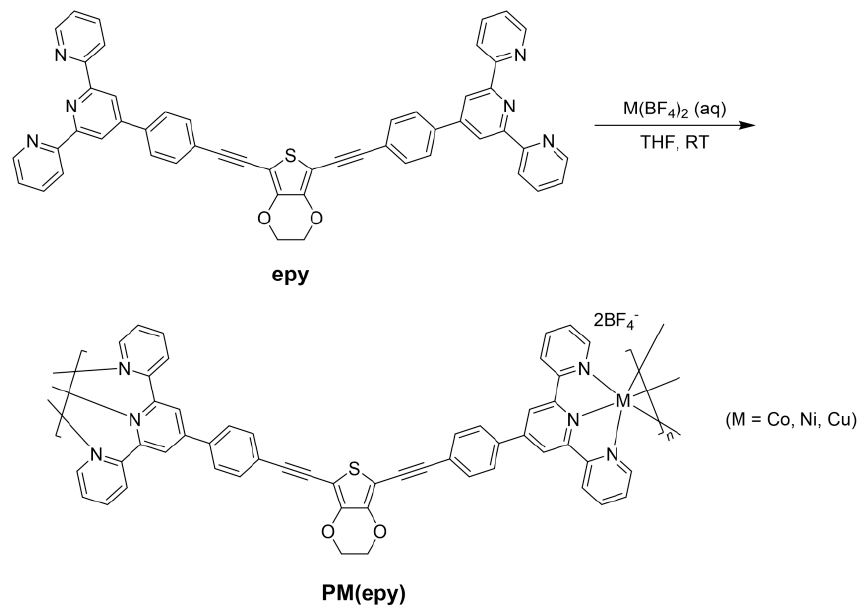
Figure 1. Synthetic route of PM(epy) .